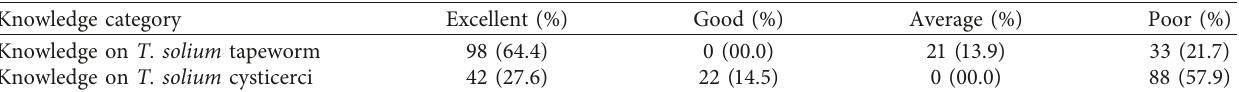
Table 3: Officers in charge of primary healthcare facilities based on knowledge levels regarding T. solium adult tapeworms and T. solium